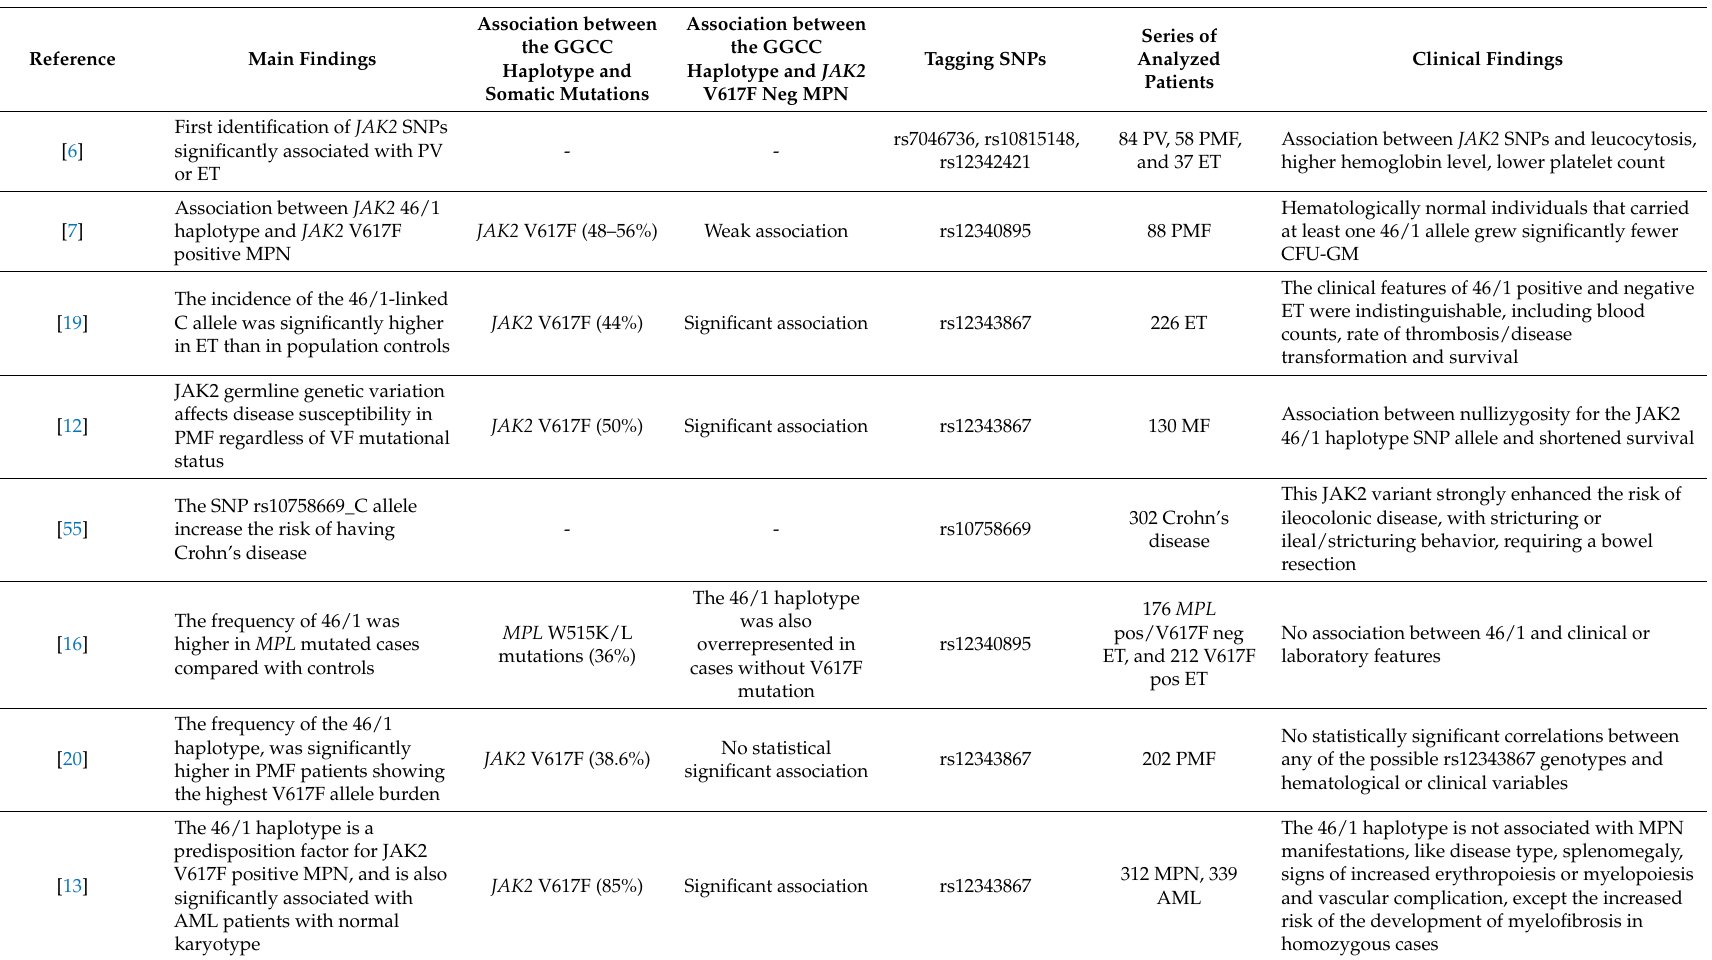
Table 1. Main literature studies describing the frequency of the JAK2 haplotype GGCC_46/1 in myeloid malignancies and possible clinical